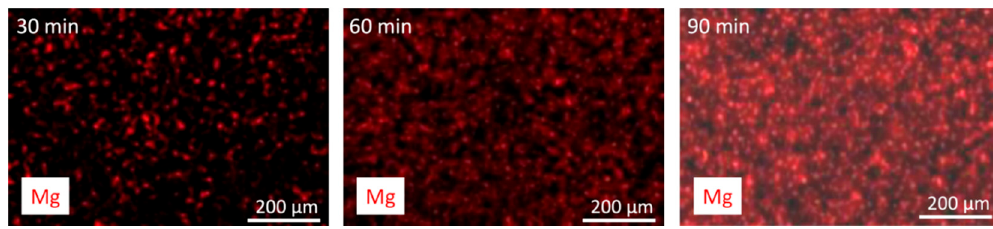
Figure 9. Elemental mapping results of Mg nanoparticles distribution on Mung bean seeds surface after 30, 60 and 90 min of the plasma treatment.